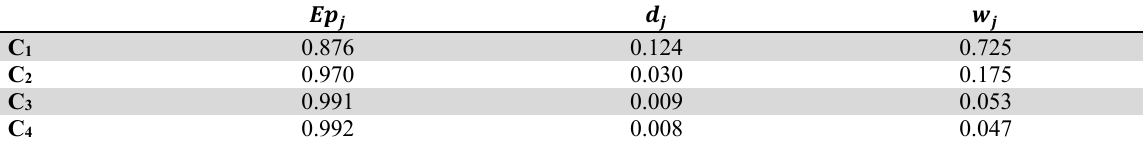
Shannon’s Entropy weight